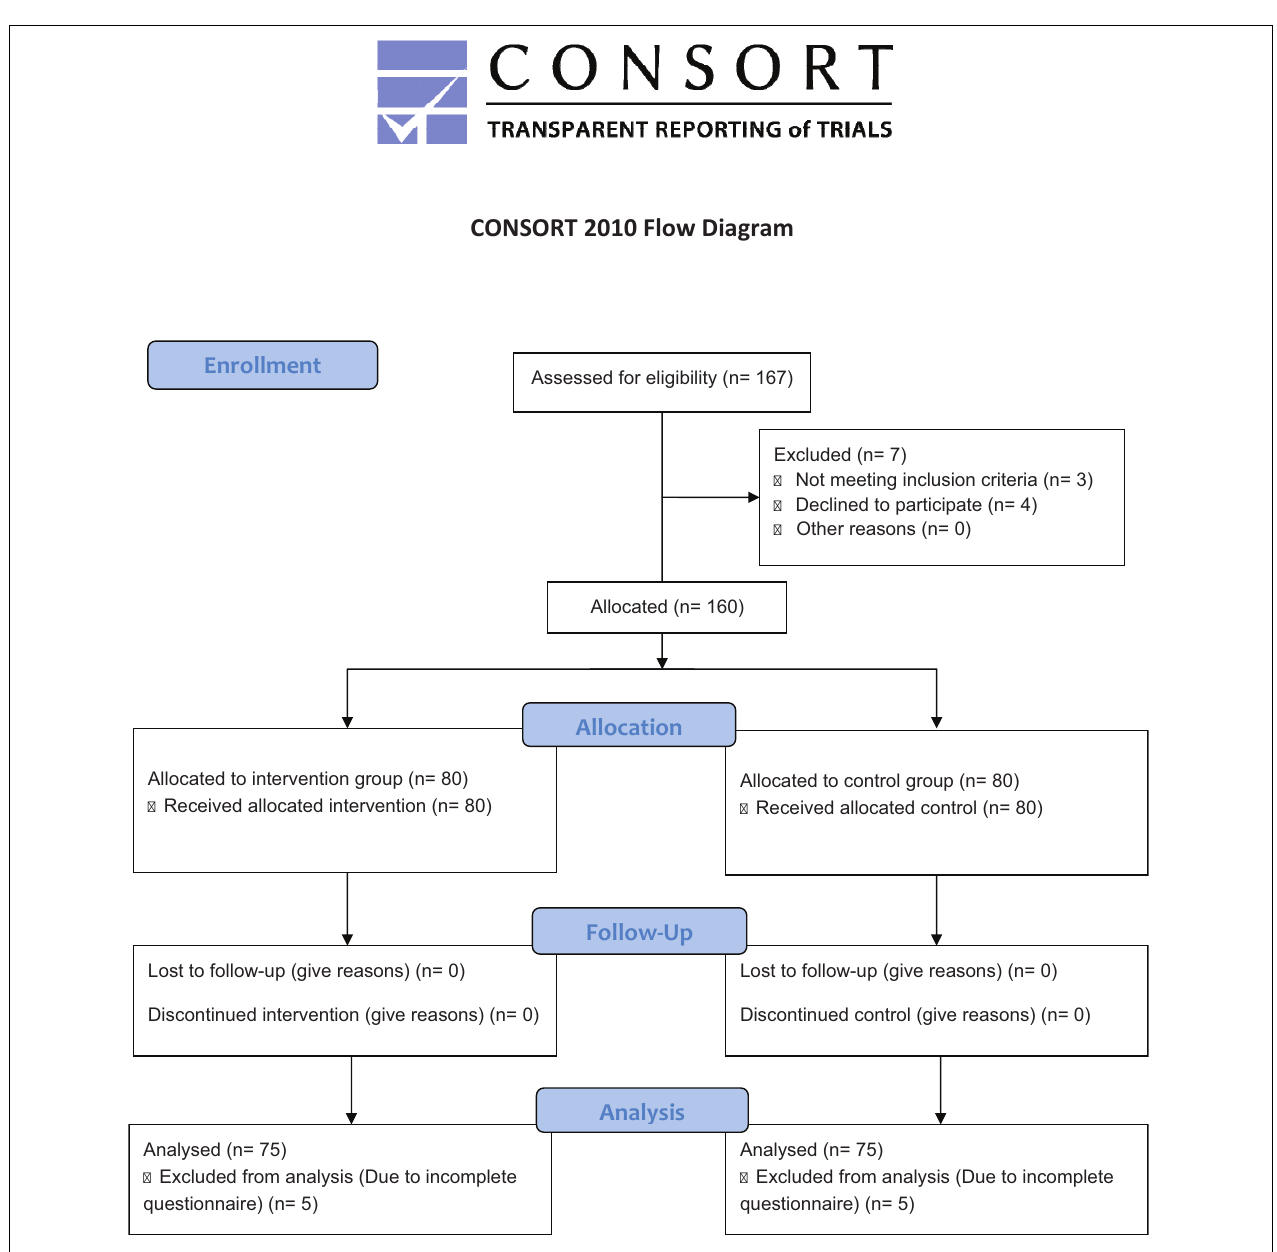
FIGURE 1 | CONSORT flow diagram for transparent reporting of trials showing the number of women eligible, those allocated, followed up, analyzed and reasons for